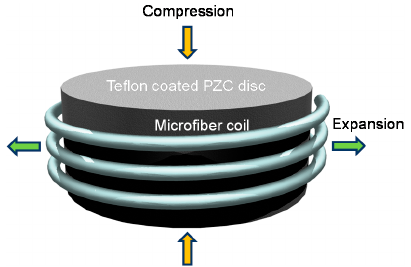
Figure 9. Schematic diagram of the microfiber coil resonator attached to the Teflon-coated piezo- electric ceramic disc.